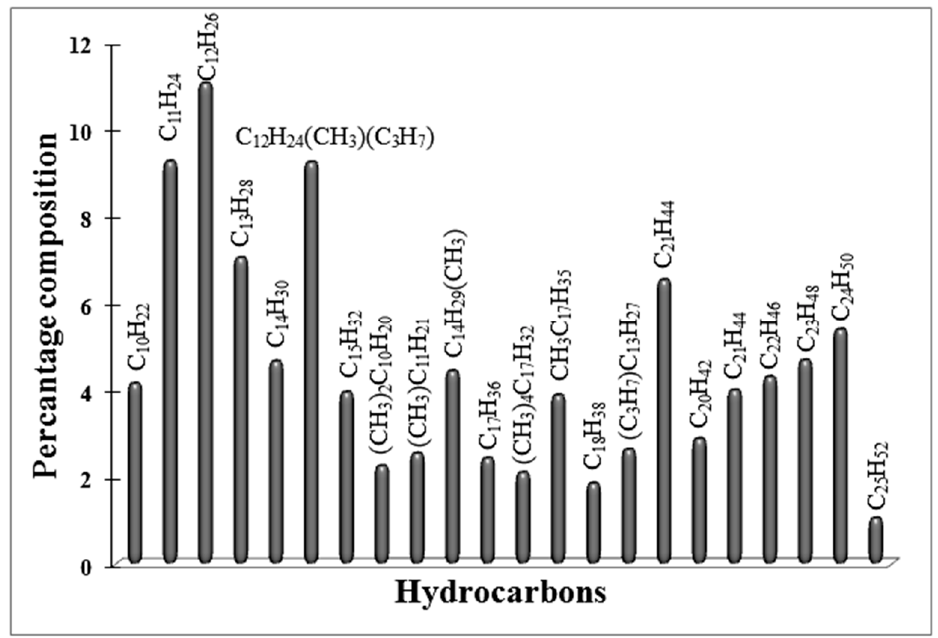
Figure 9. GC–MS analysis of liquid products obtained in FTS on Red-C-Co 5.0 SiBEA catalyst reduced at 800 °C in 100% H 2 flow.